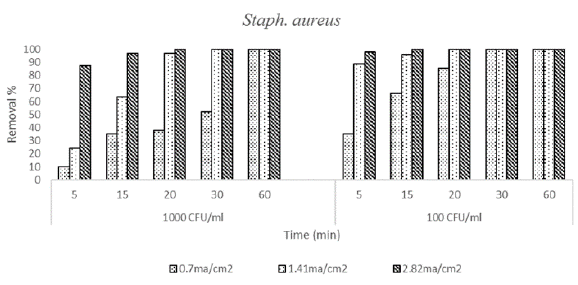
Fig.2b Percentage of live bacteria after electrochemical disinfection containing steel mesh electrode Staphylococcus